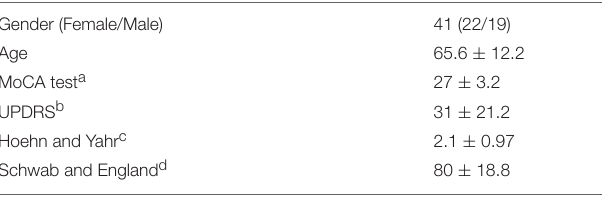
TABLE 1 | Demographic features and disease activity of Parkinson’s disease